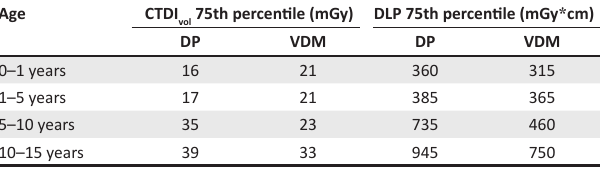
TABLE 5: Comparison of 75th percentile dose length product (mGy * cm) and volume-based computed tomography dose index (mGy) values to suggested local diagnostic reference levels.